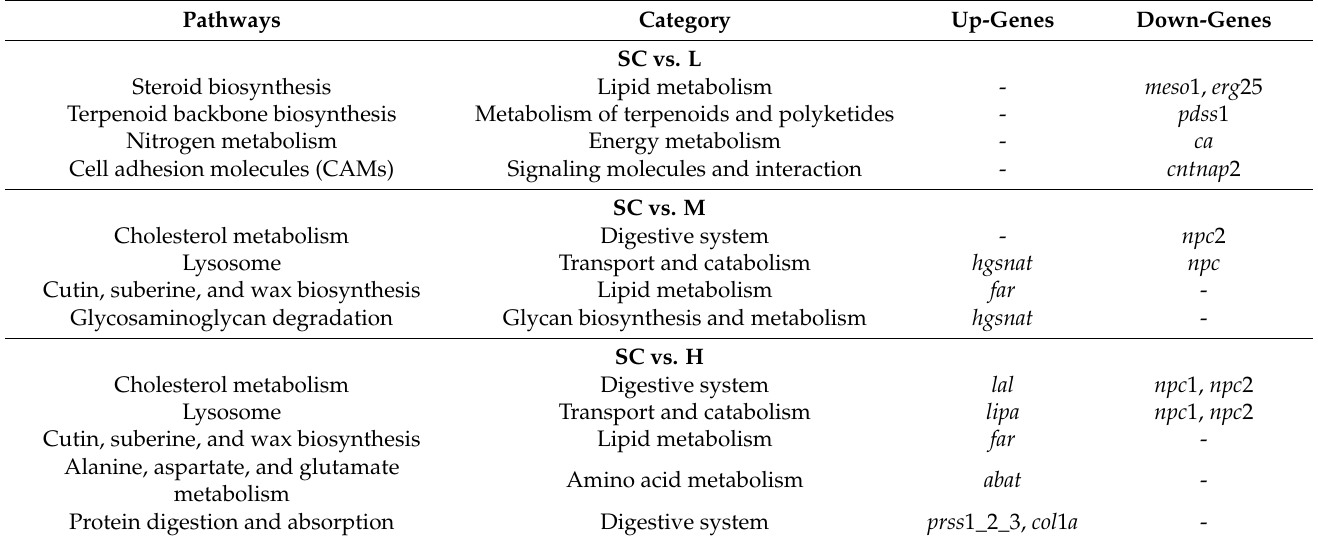
Table 1. KEGG pathways significantly enriched ( p < 0.05) in D. magna exposed to